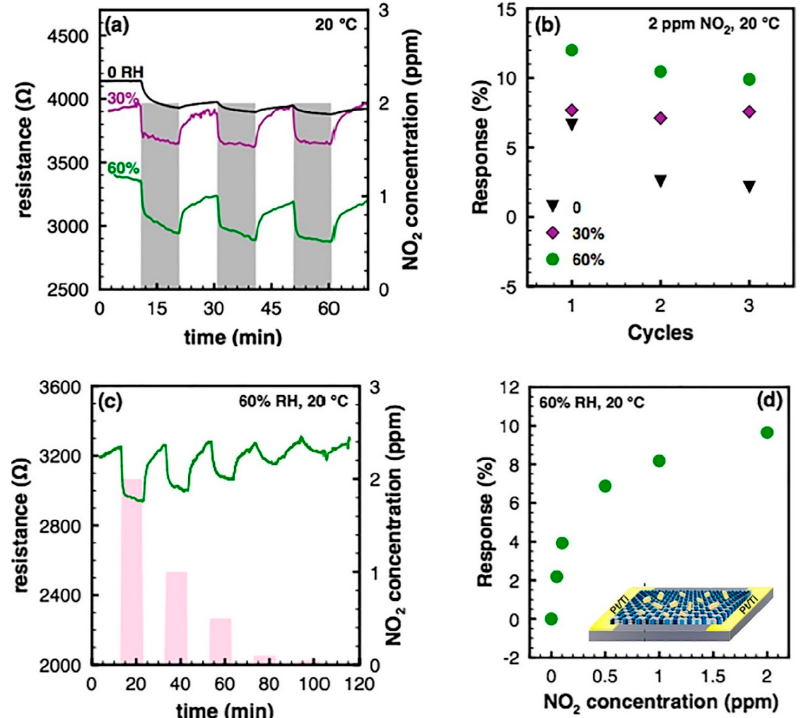
Figure 20. Panel ( a ): resistance change of the WS 2 /GA sensor to cyclic exposure to NO 2 , at different RH values; Panel ( b ): NO 2 response of the device at different RH values; Panel ( c ): electrical response of the WS 2 /GA device to different concentrations of NO 2 at RH = 60%; Panel ( d ): calibration curve of the device exposed to NO 2 at RH = 60%. Inset: sketch of the resistive WS2/GA device. (Adapted and reprinted from [196], with permission from Elsevier, Amsterdam, The Netherlands).